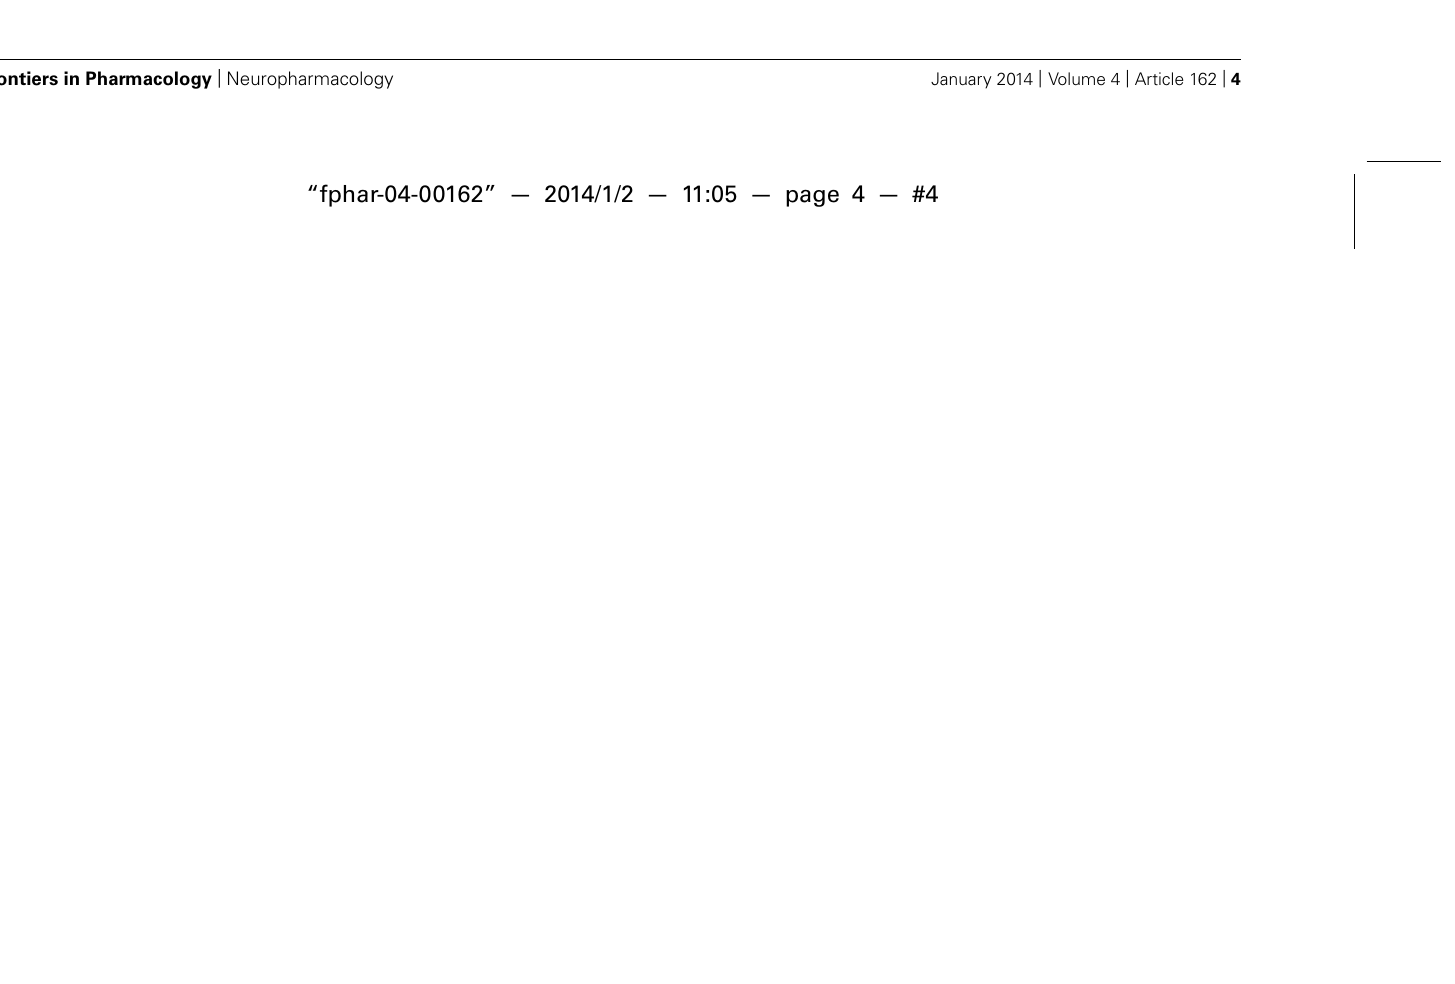
FIGURE 2 |Amoeboid versus branched phenotypes. Vehicle (0.1% DMS0), 10 nM PMA, 10 nM NAGly, 100 nM CBD, 10 nM NAGly + 100 nM CBD, 10 nM (cid:2) 9 -THC, 10 nM (cid:2) 9 -THC + 100 nM CBD. n = 5–15. * p < 0.05, ** p < 0.01 (One-way